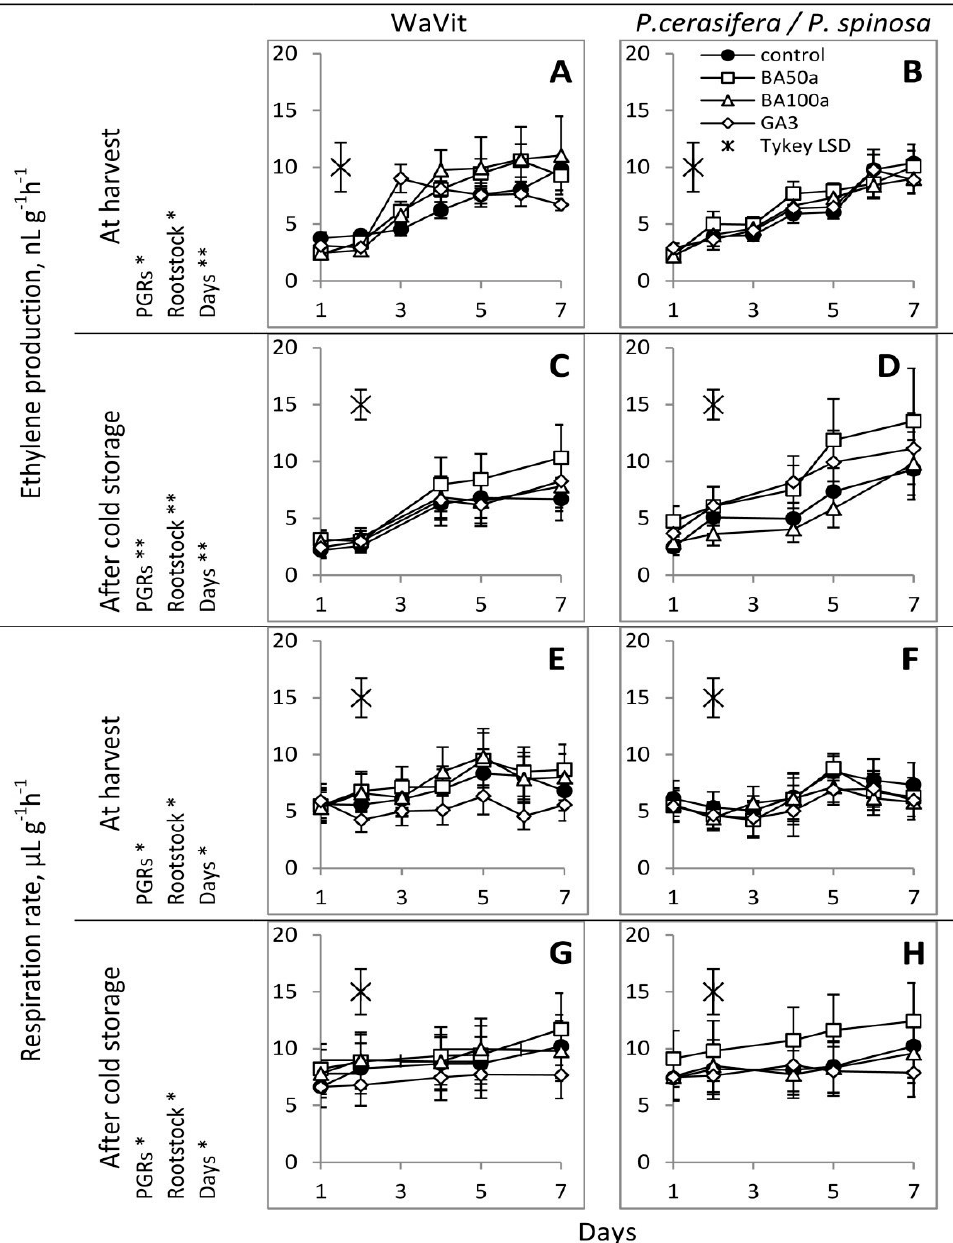
Figure 2. Ethylene production and respiration rate in fresh and stored plums grown on different rootstocks (“WaVit” and P. cerasifera / P. spinosa ) and subjected to PGR treatments. ( A – D ) Ethylene production (nL g − 1 h − 1 ): “WaVit” at harvest ( A ) and after cold storage ( C ). P. cerasifera / P. spinosa at harvest ( B ) and after cold storage ( D ). ( E – H ) Respiration rate ( µ L g − 1 h − 1 ): “WaVit” at harvest ( E ) and after cold storage ( G ). P. cerasifera / P. spinosa at harvest ( F ) and after cold storage ( H ). The main factors are presented, and their significance is annotated by: *—significant at 0.05 and **—significant at 0.01. The error bars represent the standard